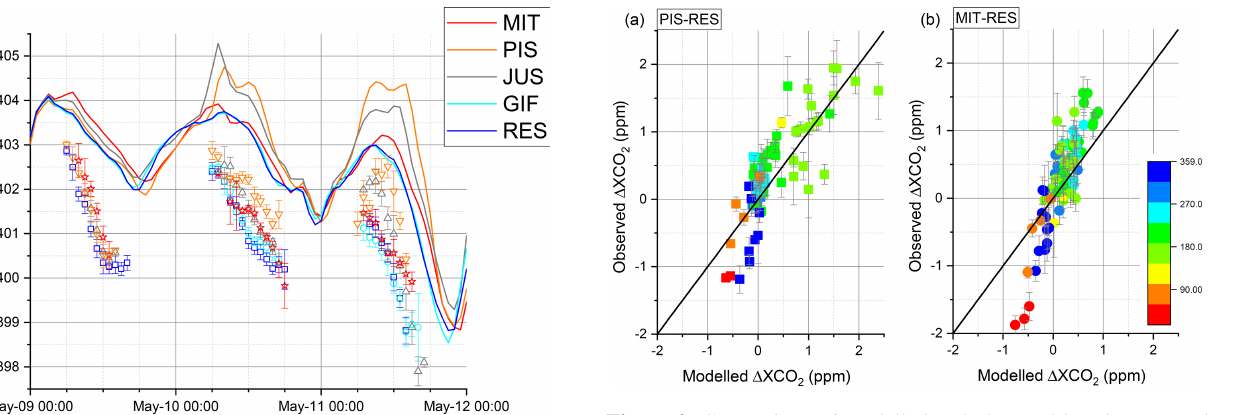
Figure 9. Comparison of modelled and observed hourly averaged (cid:49) XCO 2 for gradients between PIS and RES (a) and MIT and RES (b) , with standard deviations of the minute values of the hourly mean as vertical bars and the points colour coded by wind direction from 0 to 359 ◦